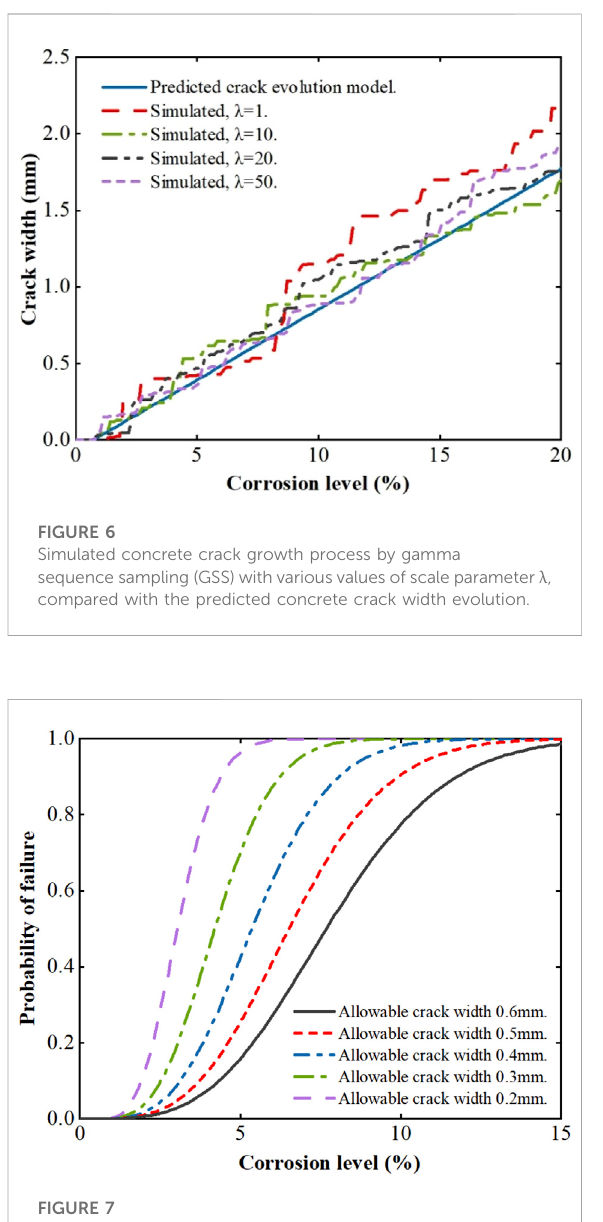
FIGURE 9 Predicted remaining useful life over time due to corrosion- induced concrete cracking with various allowable crack width